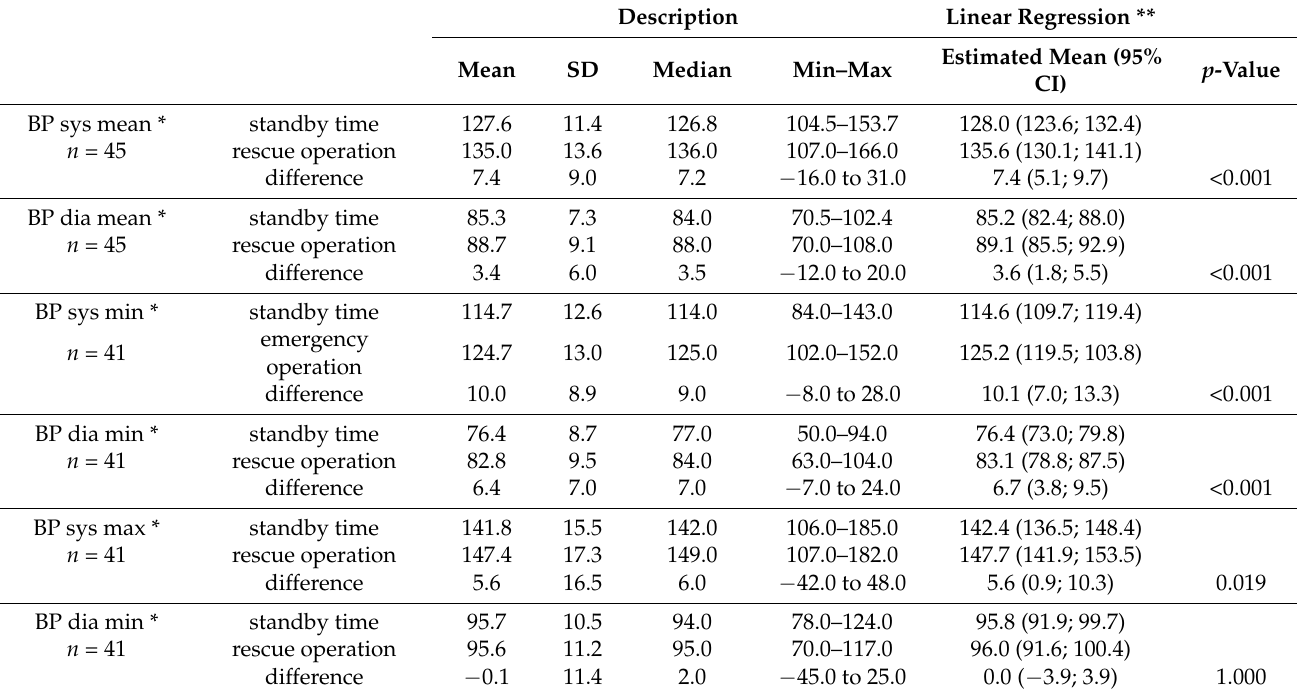
Table 2. Blood pressure values during rescue operations and in standby time.